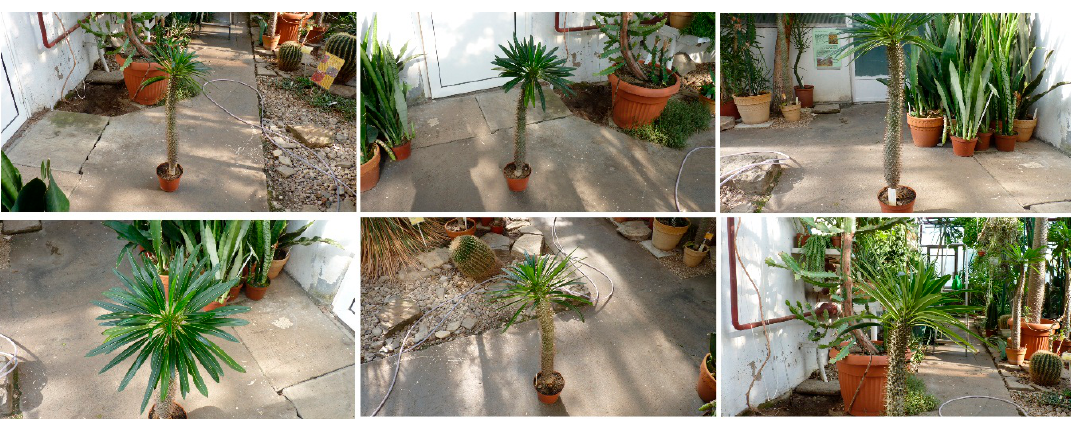
Figure 8. Several sample images from the Pachypodium lamerei series.